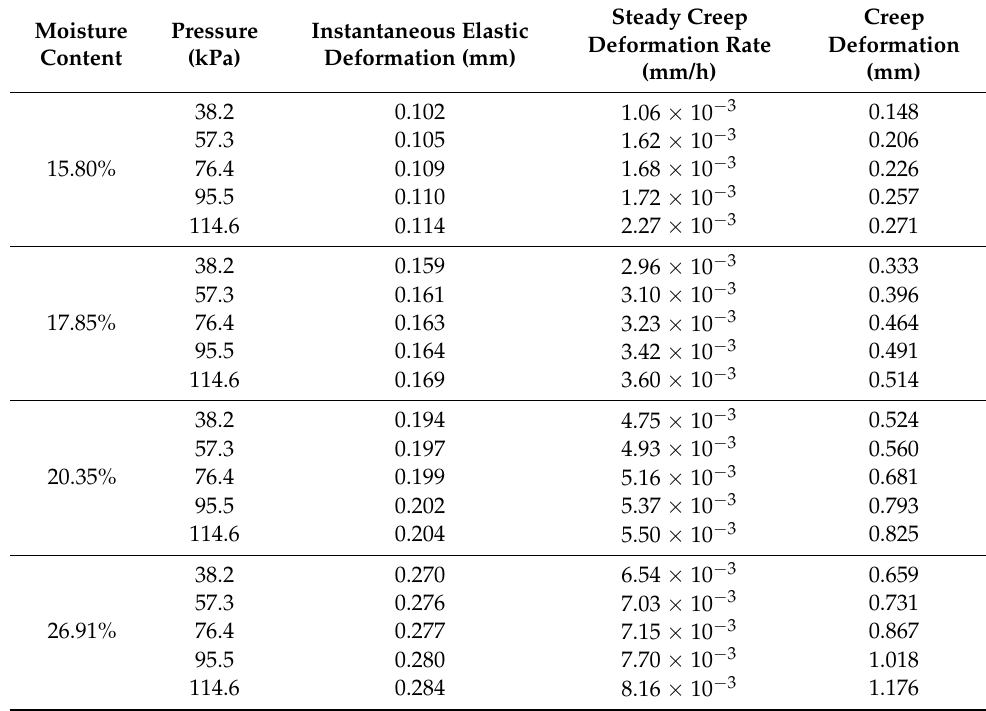
Figure 5. Strain–time curve of step loading . Table 2. Creep characteristics of specimens with different moisture contents .